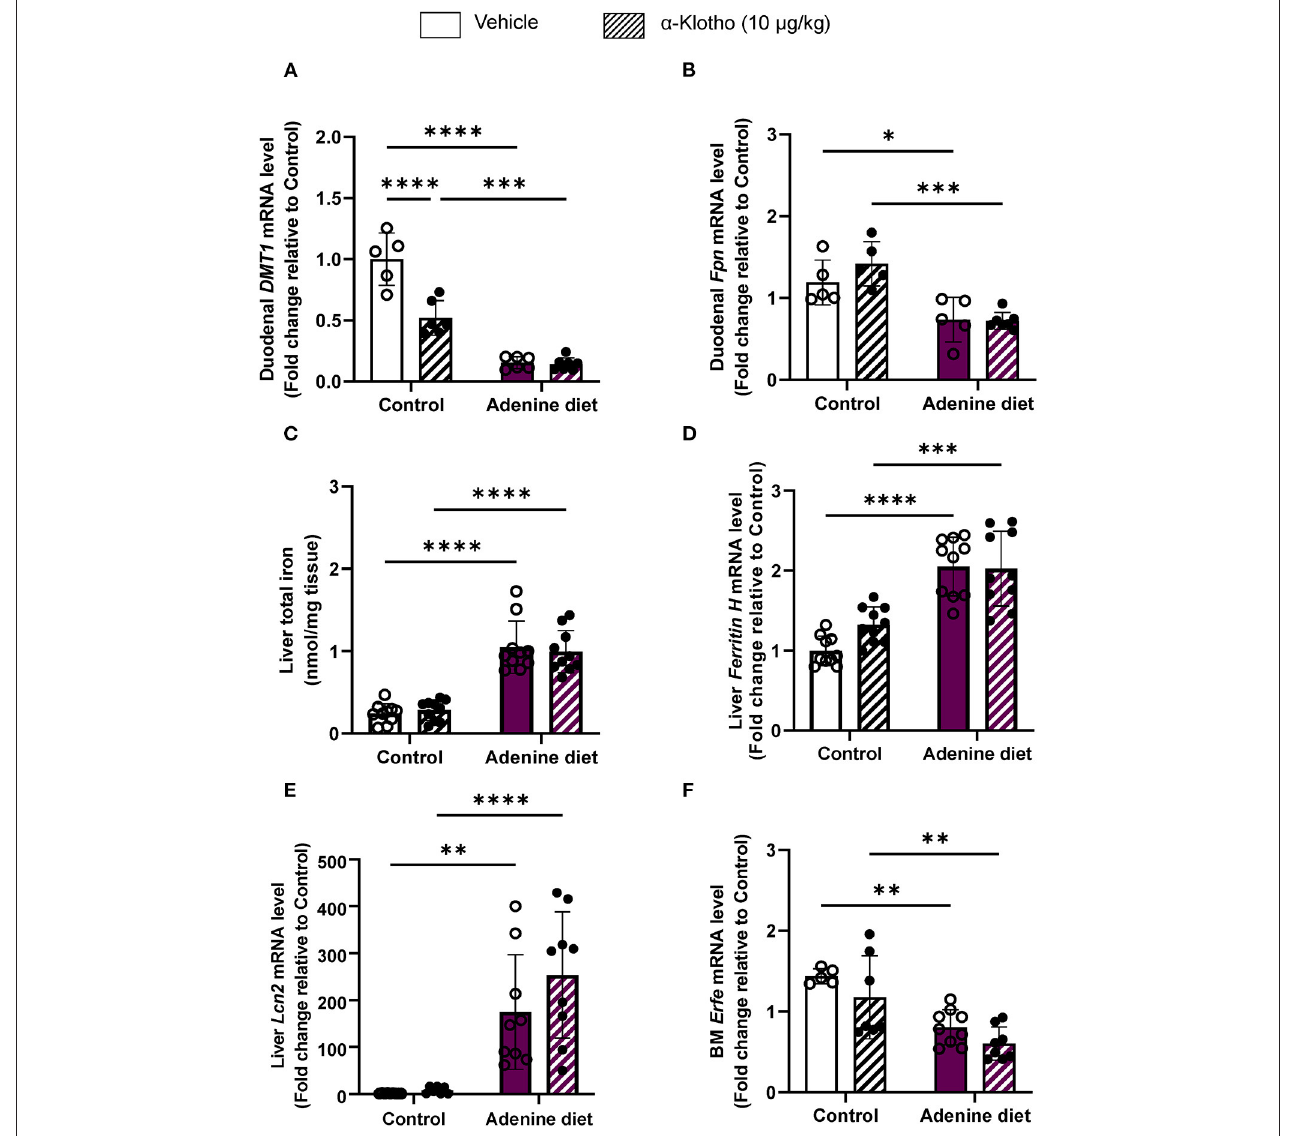
FIGURE 6 | Dysregulation of iron transport and storage in CKD. C57BL/6J male mice fed control or 0.2% adenine diet for 8 weeks were administered with either saline or mouse recombinant Klotho protein (10 ug/kg) 24h before sacrifice. Quantitative real-time RT-PCR for duodenal (A) Dmt1 and (B) ferroportin ( Fpn ) mRNA levels ( n = 5–7 per group). (C) Total iron content in the liver by colorimetric assay. Quantitative real-time RT-PCR for (D) hepatic ferritin H (E) hepatic Lipocalin 2 ( Lcn2 ) and (F) bone marrow erythroferrone ( Erfe ) mRNA expression. qRT-PCR data are expressed as fold change (2 11 Ct ) relative to housekeeping gene Hprt . Data are represented as mean ± SD ( n = 8–10 per group). * P < 0.05, ** P < 0.01, *** P < 0.001, **** P < 0.0001 compared to